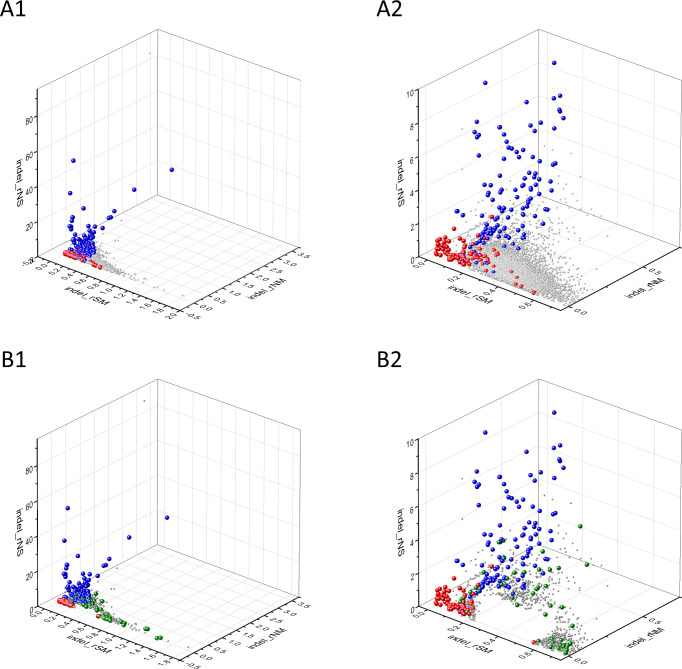
Analyses of indel_rSM, indel_rNM, indel_rNS parameters of human protein-coding genes of tumor tissues.The figure shows the results of the analysis of 13930 transcripts containing at least 100 subtle, confirmed somatic mutations from tumor tissues, including only mutations identified as not SNPs. Axes x, y, and z represent the indel_rSM, indel_rNM, indel_rNS values defined as the ratio of indel_fS/ indel_fM, indel_fN/ indel_fM, indel_fN/ indel_fS, respectively. Each ball represents a human transcript; the positions of transcripts of the genes identified by Vogelstein et al., 2013 as oncogenes (OGs, large red balls) or tumor suppressor genes (TSGs, large blue balls) are highlighted. Panels A1, A2 show the distribution of the 13,930 transcripts at different magnification. Note that the majority of human genes are present in a dense cluster but known OGs and TSGs separate significantly from the central cluster and from each other. The rNS and rNM values of TSGs are higher, whereas the rSM and rNM values of OGs are lower than those of passenger genes. Panels B1,B2 show data only for candidate cancer genes present in the CG_SO2SD_SSI2SD list (see Supplementary file 31). The positions of transcripts of the genes identified by Vogelstein et al., 2013 as OGs (large red balls) or TSGs (large blue balls) are highlighted. The positions of novel cancer gene transcripts validated in the present work are highlighted as large green balls.